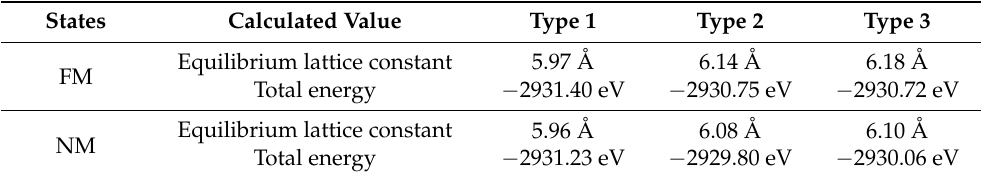
Table 2. The equilibrium lattice constant and minimum total energy of each type for both FM and NM magnetic states.